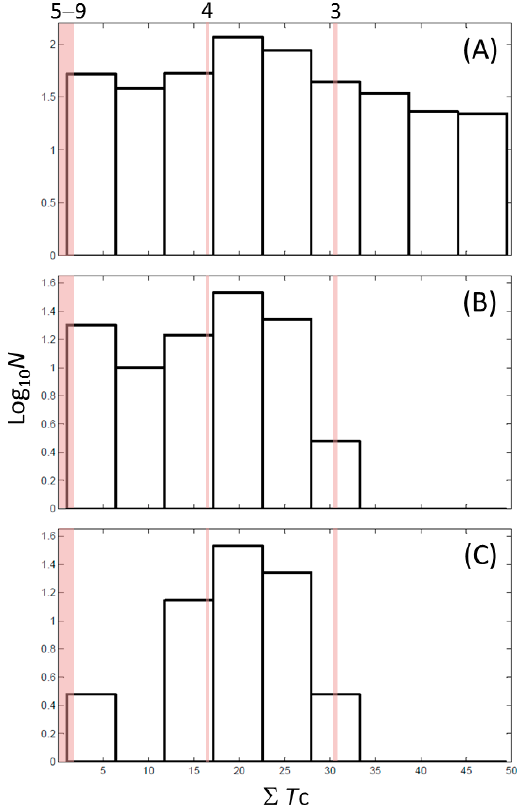
Figure 5. Chemical similarity to known tyrosinase inhibitors. Distribution of Σ T c values in ( A ) all 469 inhibitors; ( B ) 107 thione-containing inhibitors; and ( C ) 78 thiourea-containing inhibitors from BindingDB [38]. The values of Σ T c were calculated between all the inhibitors and individual sets of inhibitors. ( A – C ) have the same bin ranges in X -axis. The counts ( N ) in Y -axis are scaled logarithmically for clarity. The shaded ranges with pink colour in ( A – C ) corresponds to 3, 4, and 5–9 compounds with the values of Σ T c described in Table 4.